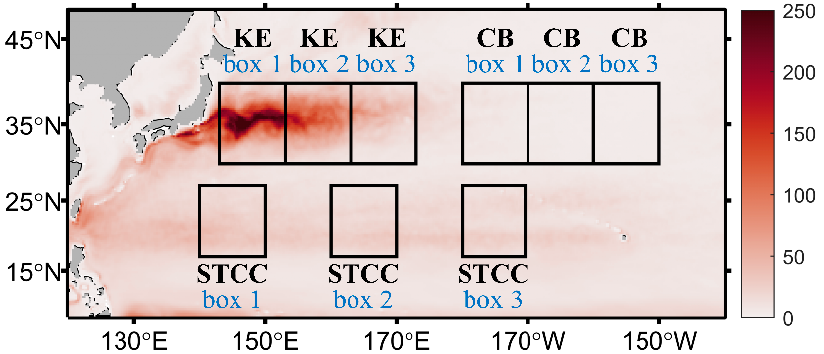
Figure 2. Time mean surface eddy kinetic energy ( u (cid:48) u (cid:48) + v (cid:48) v (cid:48) ) /2 (m 2 /s 2 ) from the ECCO2 state estimate. u’ and v’ are zonal and meridional velocity anomalies defined as the deviation from the time-mean over the years 1992–2003. The KE boxes (10 ◦ × 10 ◦ ) are located in the Kuroshio Extension, STCC in the North Pacific Subtropical Countercurrent, and CB in the central basin of the North Pacific. Equations (15) and (16) show that Π F is only one part of Π total in the budget equation of large-scale kinetic energy EKE < . The remaining part of Π total is Π total,III + Π total,IV from K Equation (15), which represent the advection of kinetic energy in the large-scale flow. The term Π total,III + Π total,IV plays a role in spatially redistributing kinetic energy, but does not contribute to the energy transfer across different scales. Therefore, Π total,III + Π total,IV does not contribute to the spectral energy flux Π F . Similarly, Π A from definition III is also part of Π total . The term Π total contains not only Π A , but also the transport terms J 1 and J 2 (first and second terms in Equation (23)). These terms redistribute energy spatially, not across different spatial scales. In addition, the derivation of Π A assumes that the fluid is two- dimensional and incompressible ( ∂ u / ∂ x + ∂ v / ∂ y = 0). This assumption also contributes to the difference between Π total and Π A